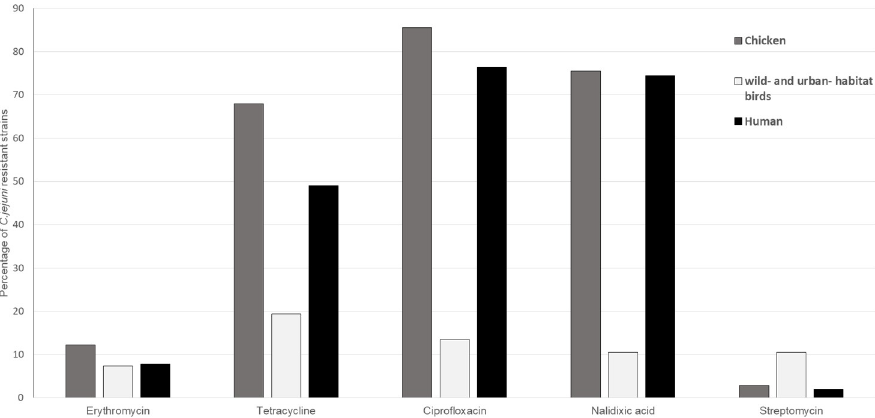
Fig 1. Percentage of C . jejuni strains isolated from chickens, birds from wild and urban habitats, and from humans showing resistance to antimicrobials (shown on the x-axis).